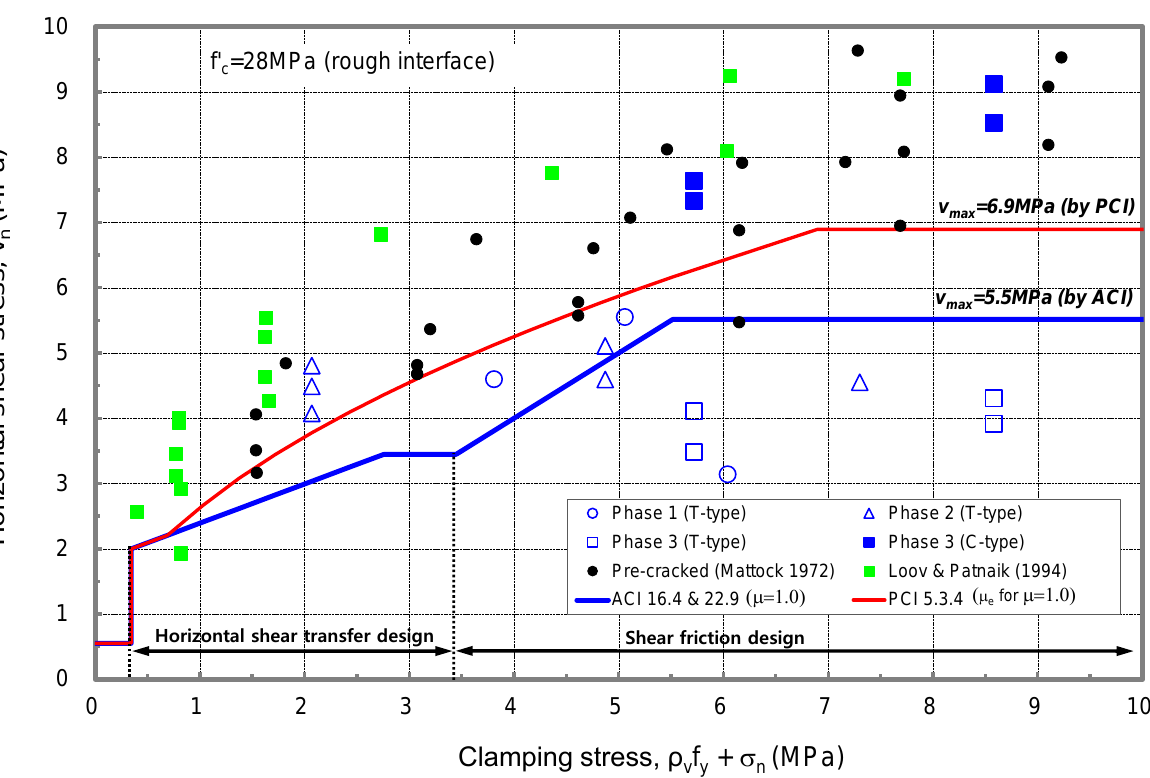
Figure 6. Comparison of observed and calculated interface shear strengths.